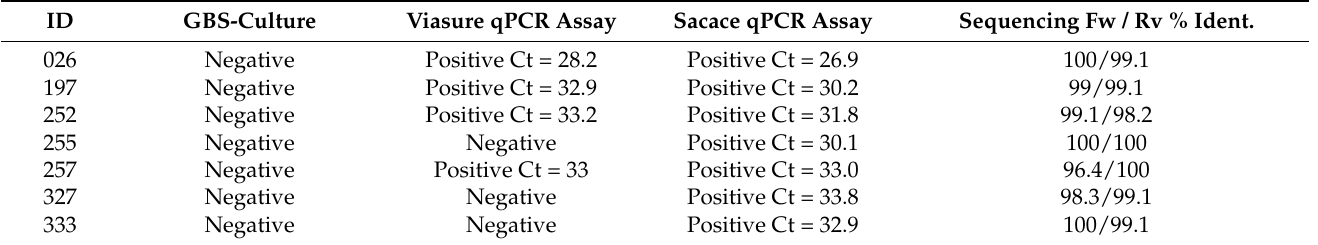
Table 2. Discrepancies in GBS detection among GBS culture, Viasure qPCR and Sacace qPCR assays, and sequencing results.